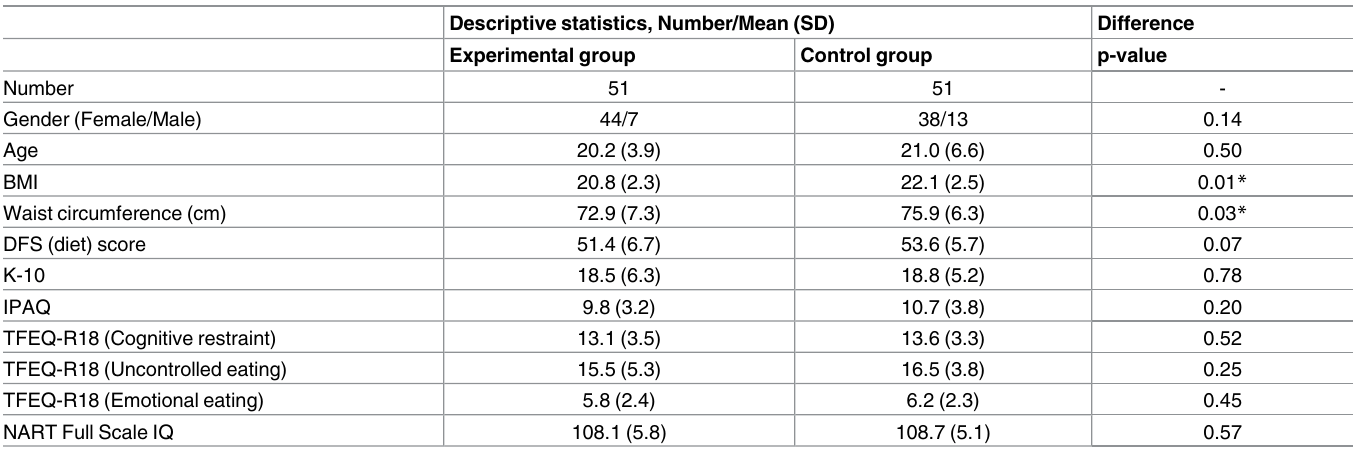
Table 2. Baseline descriptive statistics for each group.